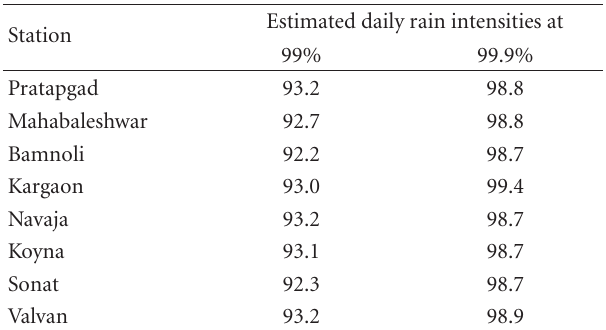
Table 4: Estimated daily rain intensities at 99% and 99.9% level for the stations in the Koyna